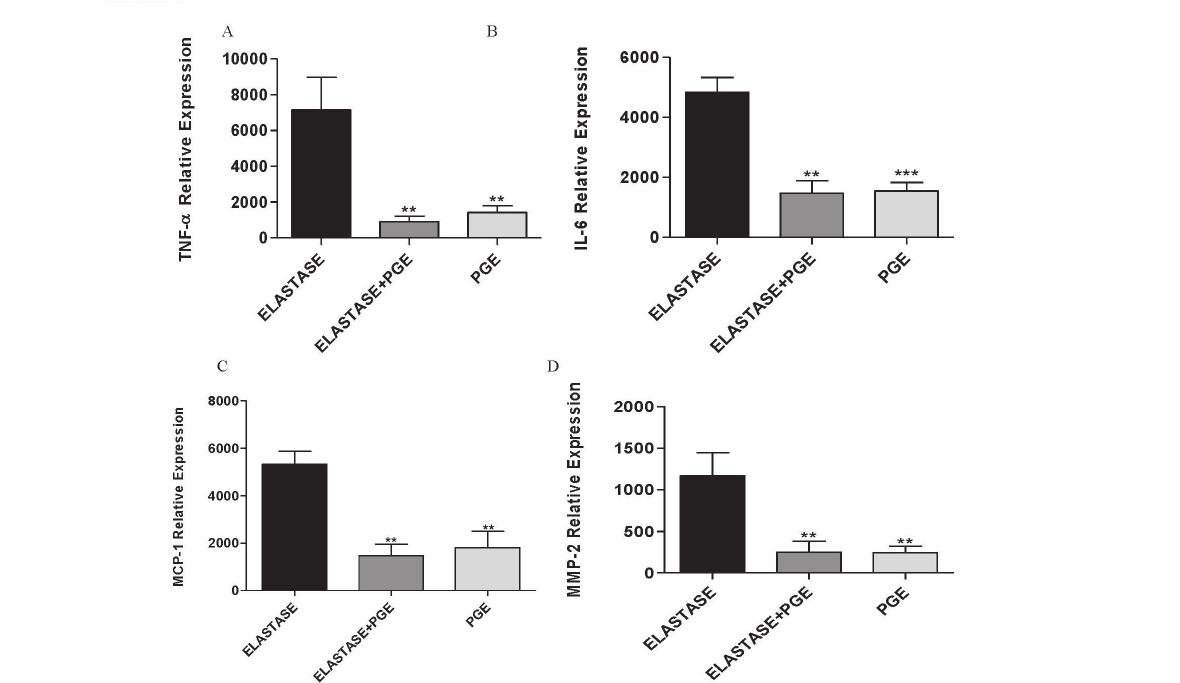
FIGURE 5 – Gene expression in 7 days after saline or Elastase instillation (D9) in animals receiving Saline solution, Elastase, and PGE alone and Elastase + PGE. Quantification of mRNA expression of TNF-a (A), IL-6 (B), MIP-1 (C) and MMP-2 genes at D9 by RT-qPCR. Data are expressed as the ratio to GAPDH as housekeeping gene. **: p < 0.01 vs Elastase. n =